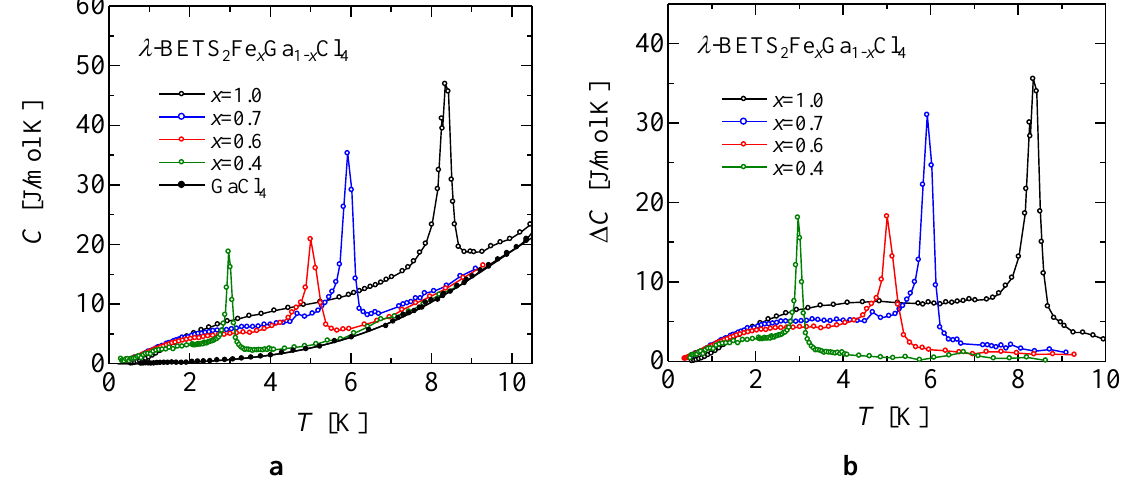
( a ) Temperature dependence of specific heat for mixed crystals λ-BETS Fe Ga Cl (○) and λ-BETS 2 x 1− x 4 λ-BETS FexGa Cl obtained by subtracting lattice and electric specific heats estimated 2 1− x 4 for λ-BETS GaCl 2 4